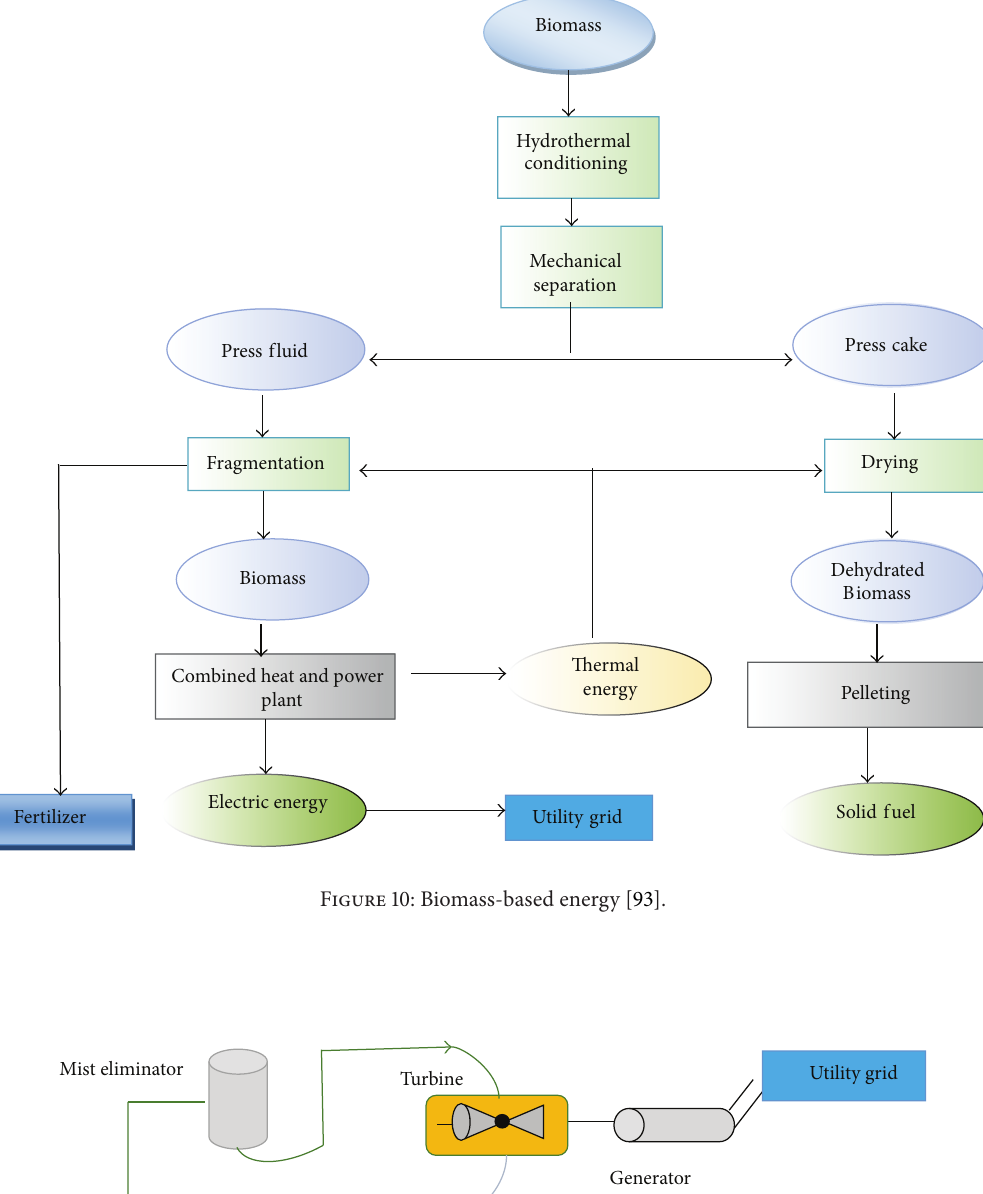
Figure 10: Biomass-based energy [93].